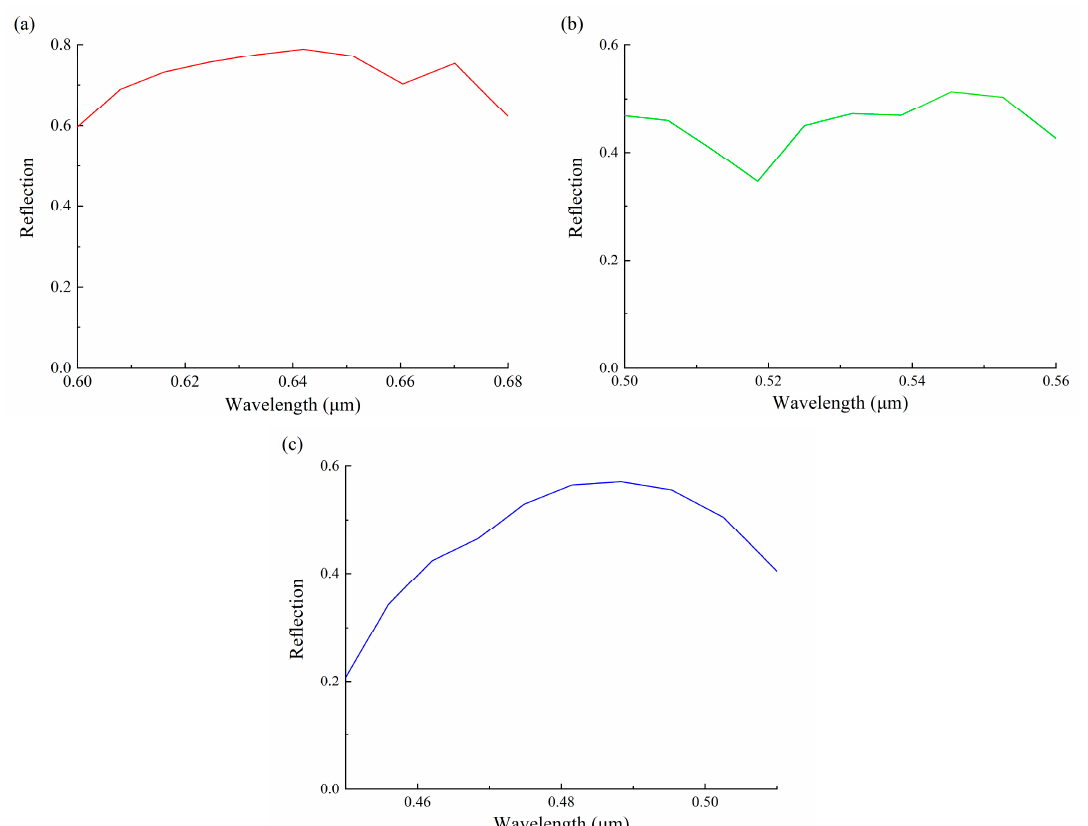
Figure 9. The corresponding reflection spectra of the letter T with different nanostructures. ( a ) The reflection spectra of letter T with D = 190 nm and p = 290 nm for every nanostructure, λ varies from 600 nm to 680 nm. ( b ) The reflection spectra of letter T with D = 115 nm and p = 290 nm for every nanostructure, λ varies from 500 nm to 560 nm. ( c ) The reflection spectra of letter T with D = 100 nm and p = 190 nm for every nanostructure, λ varies from 450 nm to 510